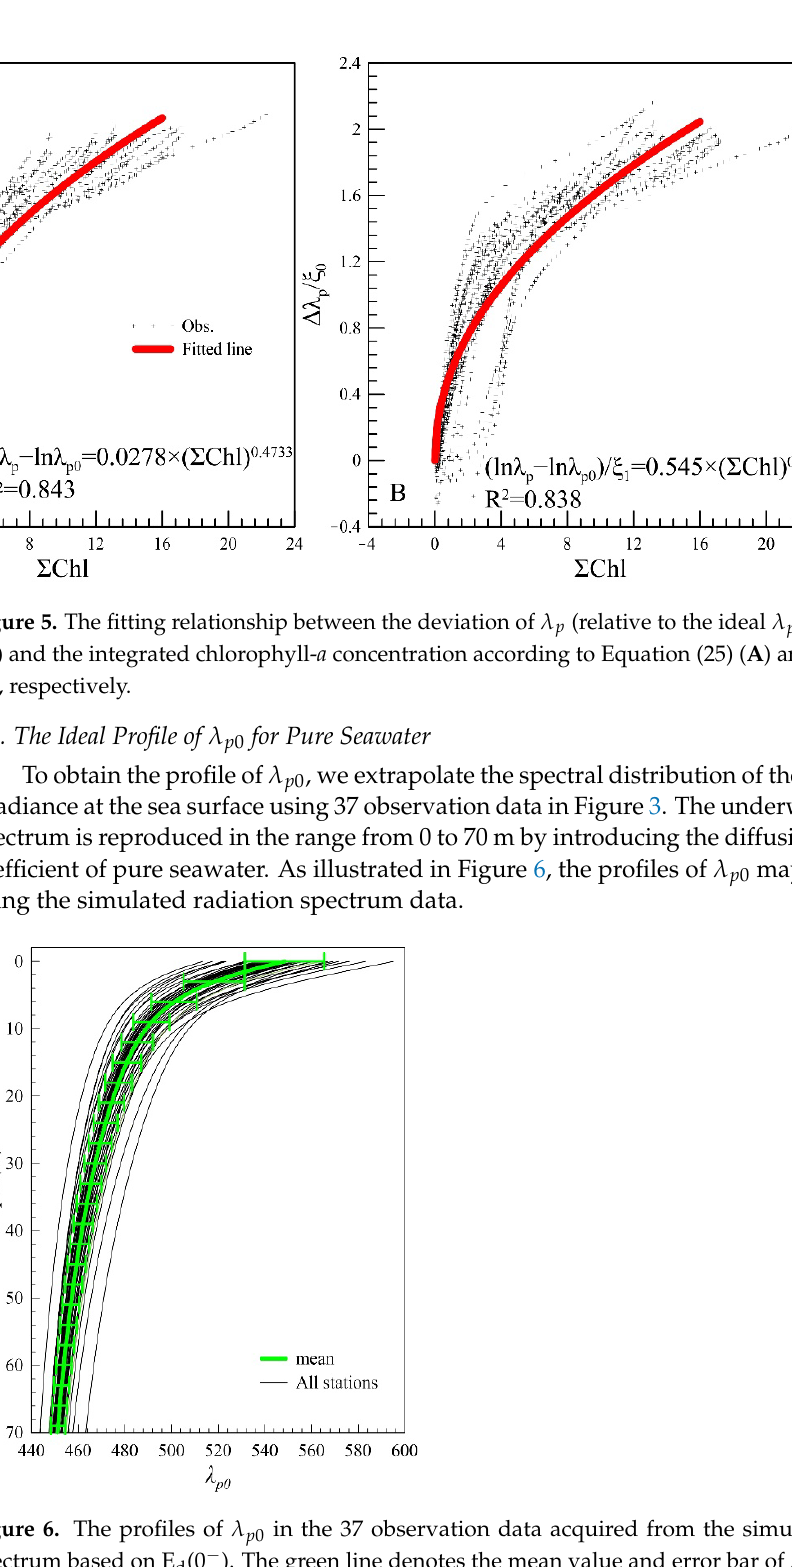
Figure 6. The profiles of λ p 0 in the 37 observation data acquired from the simulation radiation spectrum based on E d (0 − ). The green line denotes the mean value and error bar of λ p 0 .